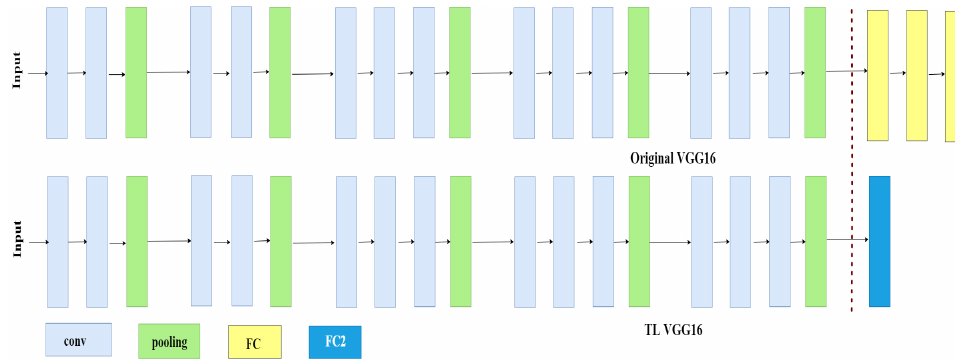
Figure 7. VGG16 and TL VGG16 architectures.